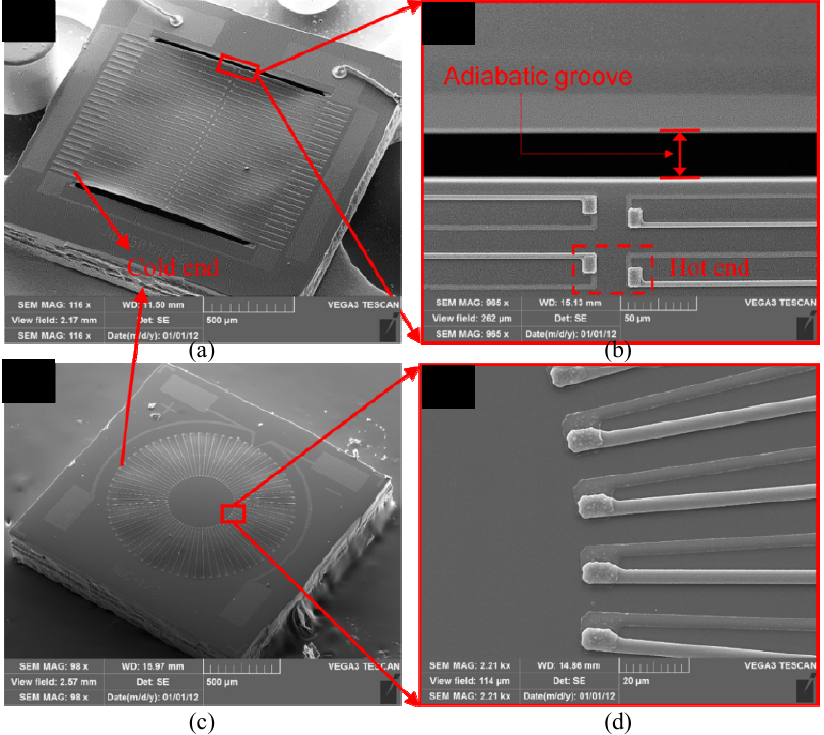
Fig. 5 Designed thermopile SEM image: (a) double-ended symmetrical rectangular thermopile, (b) adiabatic groove of double-ended symmetrical rectangular thermopile, (c) circular thermopile, and (d) layout of the hot end of the circular